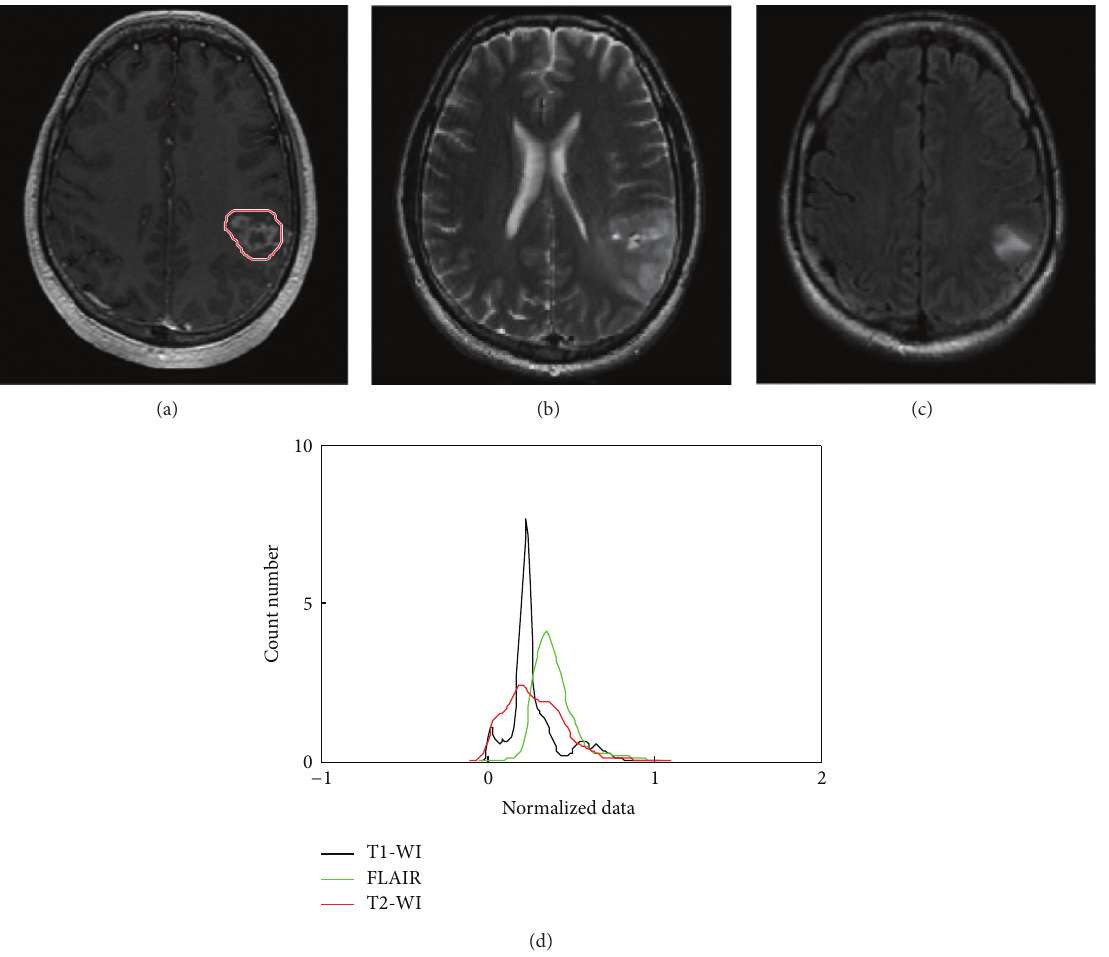
Figure 1: Analysis of GBM schema: (a) brain tumor image on axial T1-WI, (b) axial T2-WI, (c) axial FLAIR sequence, and (d) GBM data fitting in three MR